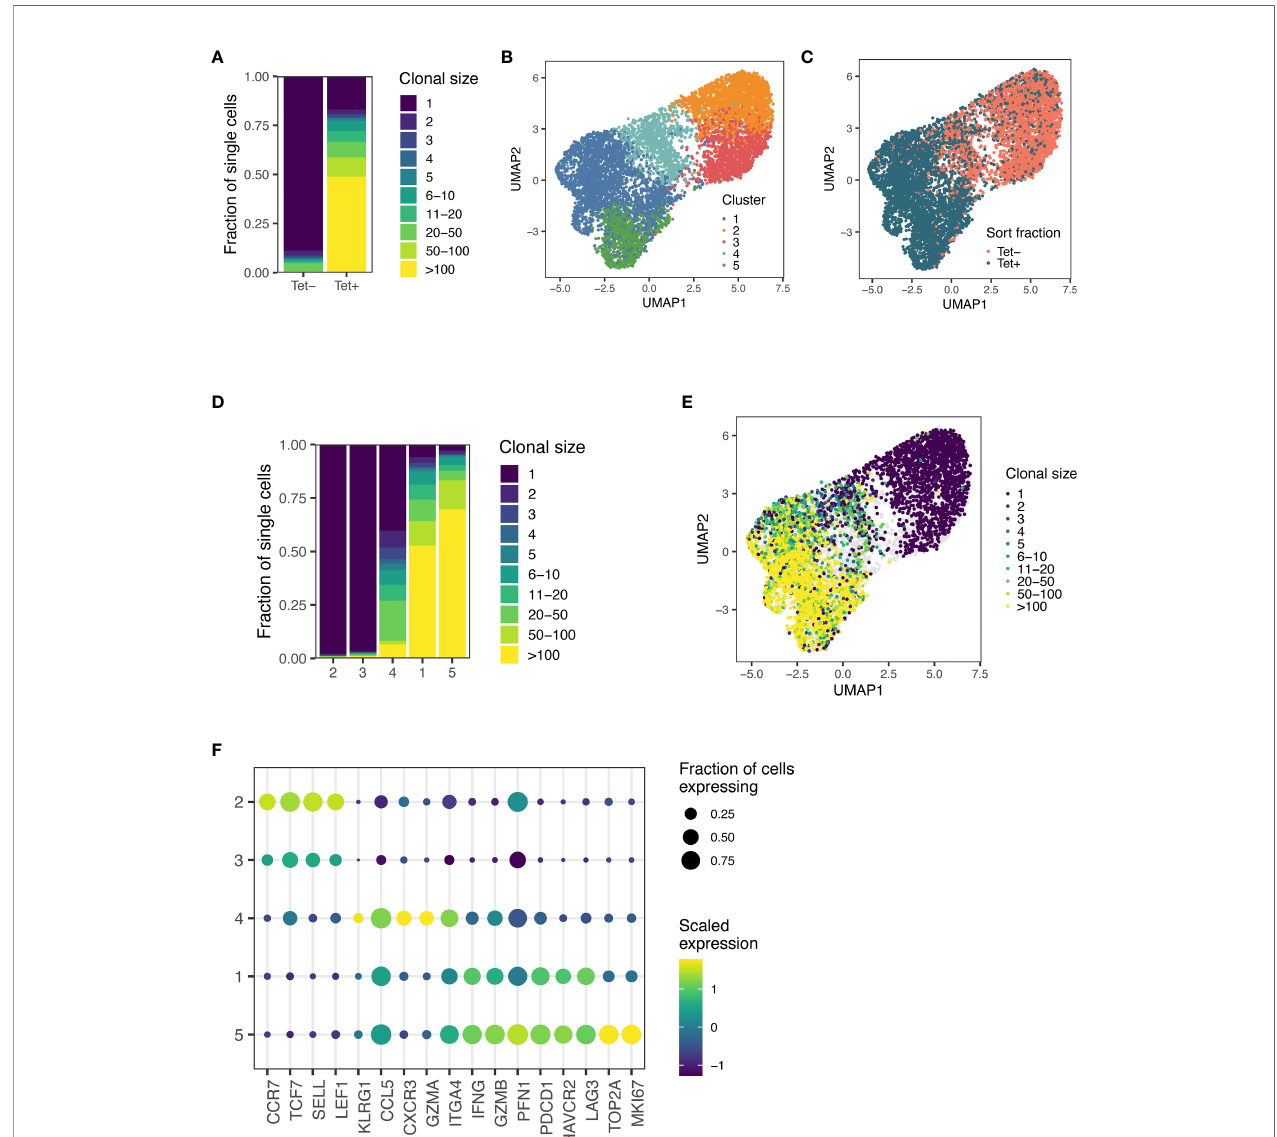
FIGURE 3 | Sequencing of T cells from AIP-treated melanomas reveals signi fi cant expansion in the p15E-tetramer + fraction. (A) Clone sizes in tetramer-positive and tetramer-negative populations from TILs isolated from AIP-treated mice as revealed by single-cell T cell sequencing. (B) Unsupervised gene expression analysis of CD8 + TILs reveals fi ve distinct transcriptomic clusters. (C) Distribution of tetramer-positive and tetramer-negative cells amongst the 5 clusters. (D) Clusters 1 and 5 show enrichment for expanded clonal TCR sequences. (E) Clone sizes of isolated TILs mapped onto the clusters as determined in (B) . (F) Expression of a selection of T cell effector and phenotype genes for each transcriptomic cluster. Scaled expression of common genes is indicated by color, and the fraction of cells in that cluster expressing the gene is indicated by relative dot